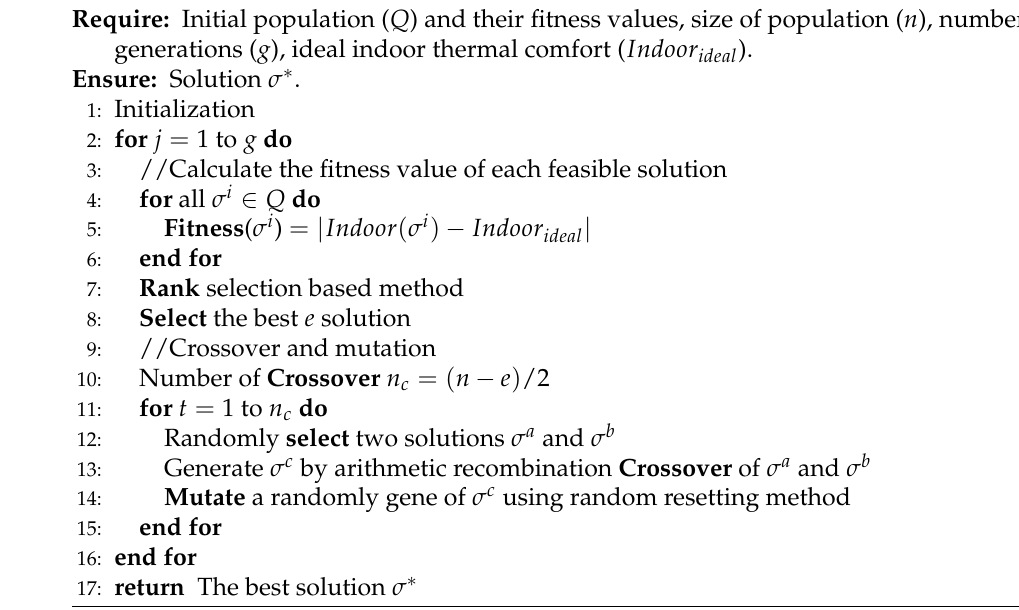
Algorithm 2 Our Genetic Algorithm